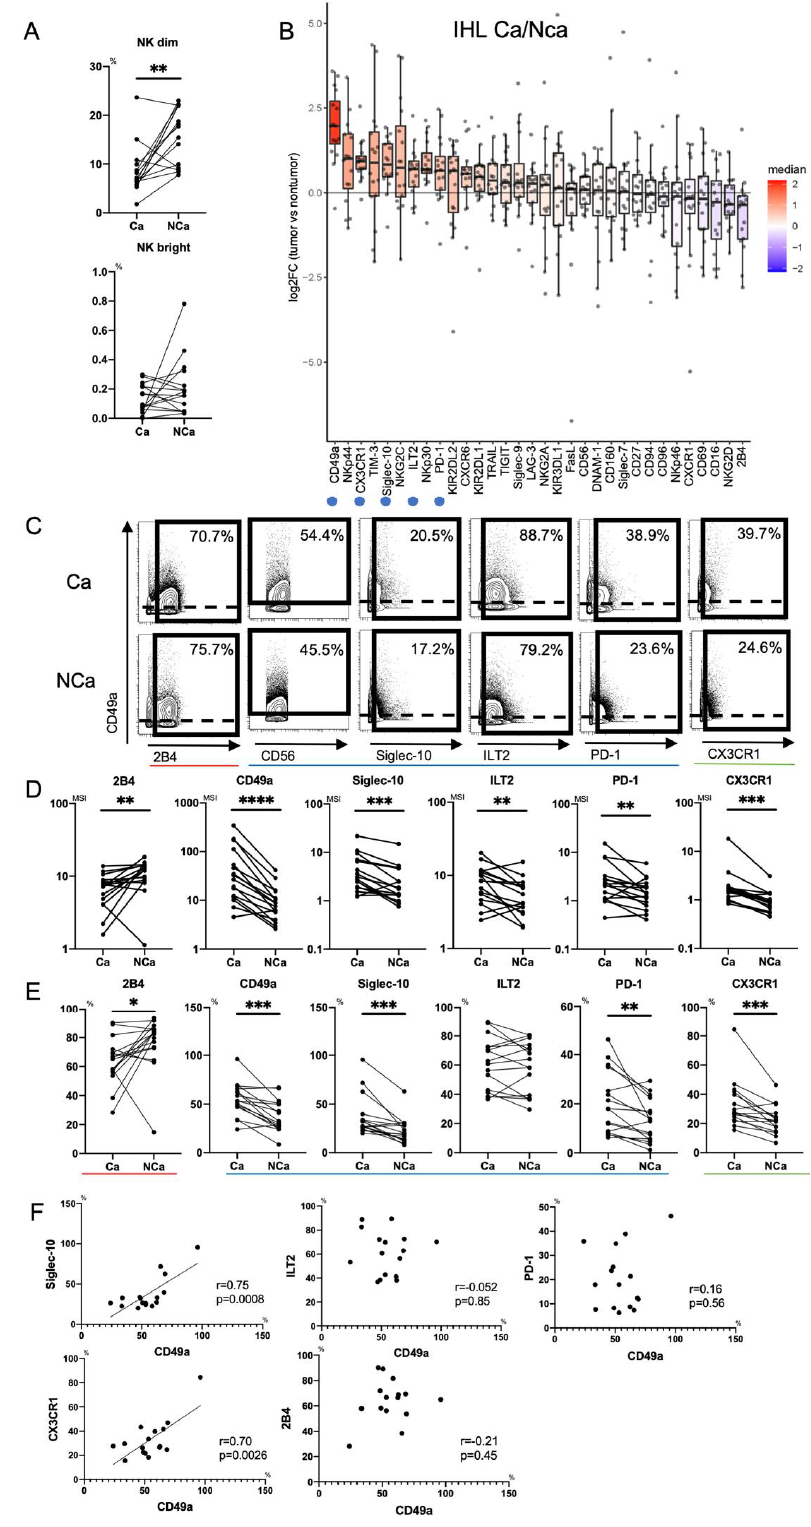
Figure 3. Phenotypic characterization of intrahepatic CD56 dim NK cells from HCC tissues. ( A ) Percentages of intrahepatic CD56 dim NK cells (CD45 + CD3 − CD14 − CD19 − CD56 dim ) and CD56 bright NK cells (CD45 + CD3 − CD14 − CD19 − CD56 bright ) from HCC tissue (Ca) and non-cancerous adjacent liver tissue (NCa) in 16 HCC patients. ** p < 0.01; *** p < 0.001 by the paired t -test. ( B ) Relative expression of surface markers on Ca-CD56 dim NK cells and NCa-CD56 dim NK cells ( n = 16).